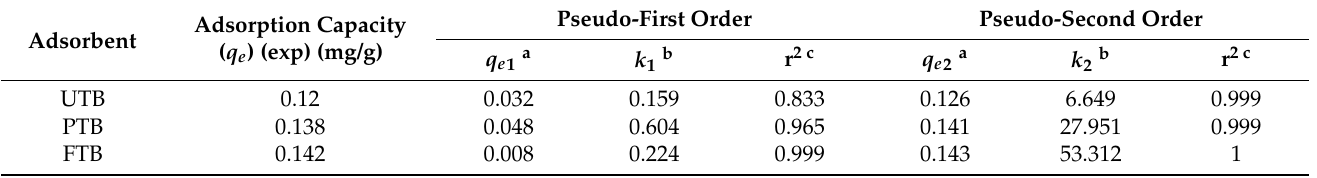
Table 2. Kinetic parameters of congo red adsorption for untreated sugarcane bagasse (UTB), alkali and ionic liquid pretreated sugarcane bagasse (PTB), and fermented sugarcane bagasse (FTB). Adsorption Adsorbent